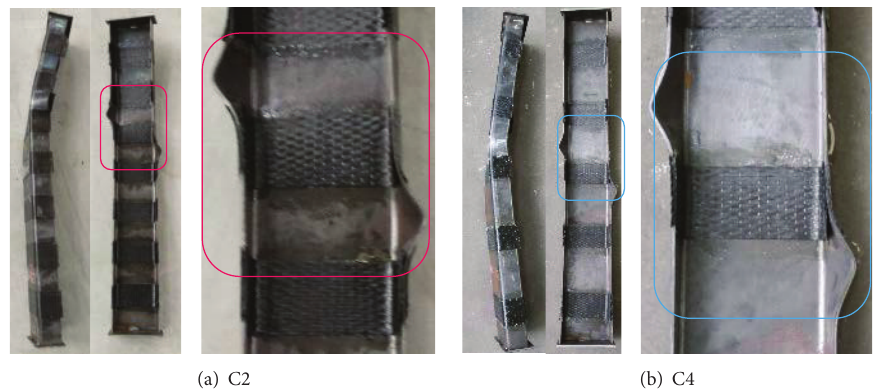
Figure 5: Failure modes of specimens exhibiting flexural torsional buckling prior to flange local buckling.